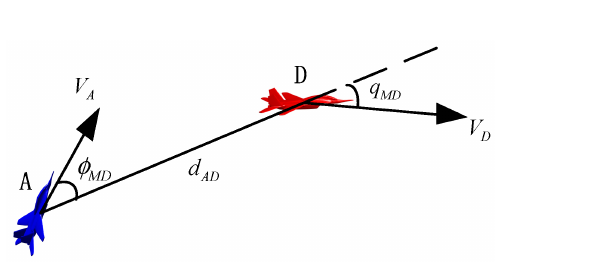
Figure 1. The position relationship between two fighters.